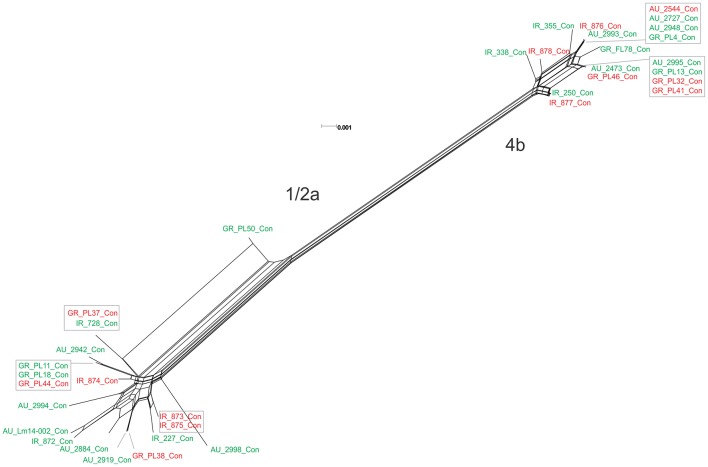
Phylogenetic network applied to virulence gene cluster prfA (pVGC; concatenated genes prfA, plcA, hly, mpl, actA, and plcB) using the Neighbor-Net algorithm. L. monocytogenes strains represented food environment isolates (green color) or clinical isolates (red color), isolated in Ireland (IR), Greece (GR), and Australia (AU). Strains clustered together in a box represent identical nucleotide sequence.